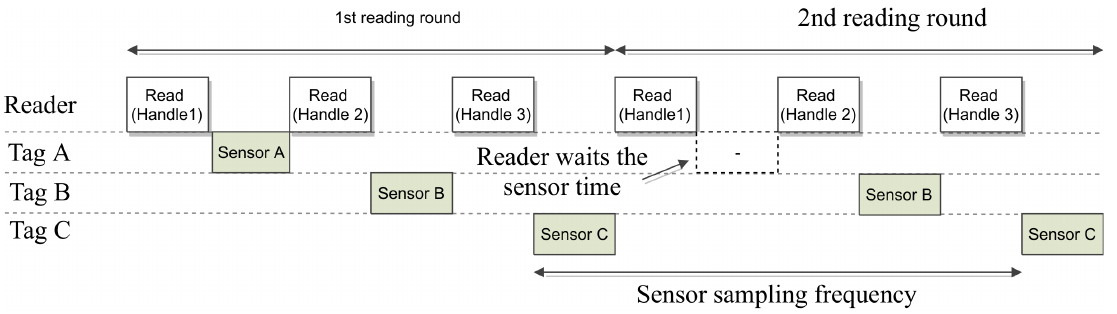
Figure 4. Example of two Read rounds using sensor Frame Slotted Aloha protocol (sFSA) ( N = 2, S =